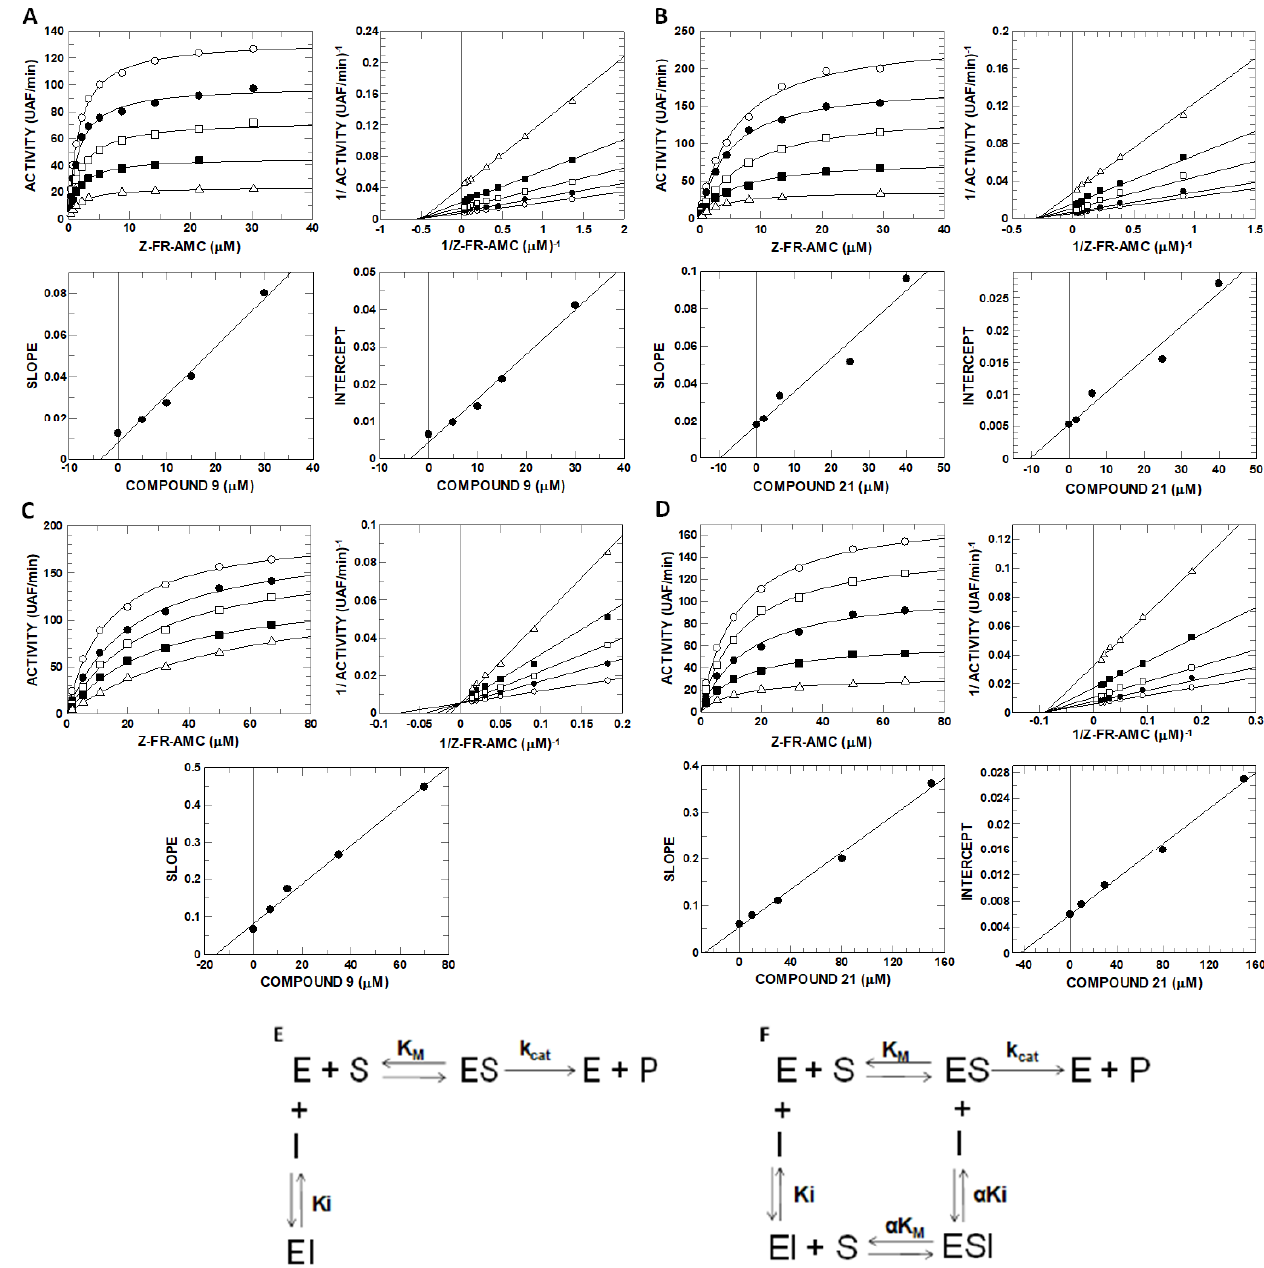
Figure 7. Kinetic inhibition mechanism evaluation and inhibition constant determination of com- pounds C9 and C21 with cathepsins B and L. Compounds C9 and C21 were assayed against cathep- sins B and L at different concentrations of the substrate Z-FR-AMC and compounds. ( A ) Cathepsin L and compound C9 ; ( B ) Cathepsin L and compound C21 ; ( C ) Cathepsin B and compound C9 ; ( D ) Cathepsin B and compound C21 ; ( E ) Simple linear competitive mechanism that provides only the K i profile from ( C , F ) Simple linear noncompetitive mechanism that provides the Ki and α K i profile from ( A , B , D ).